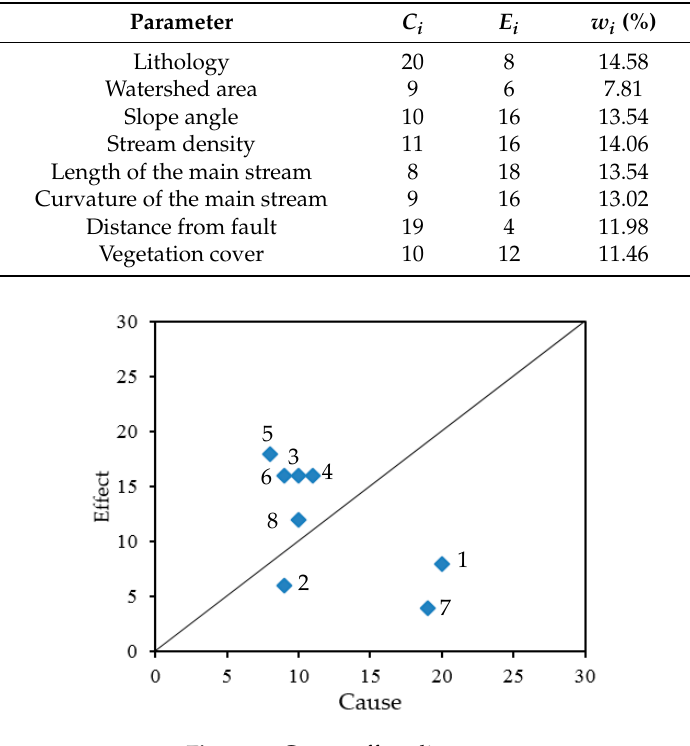
Figure 7. Cause–effect diagram.